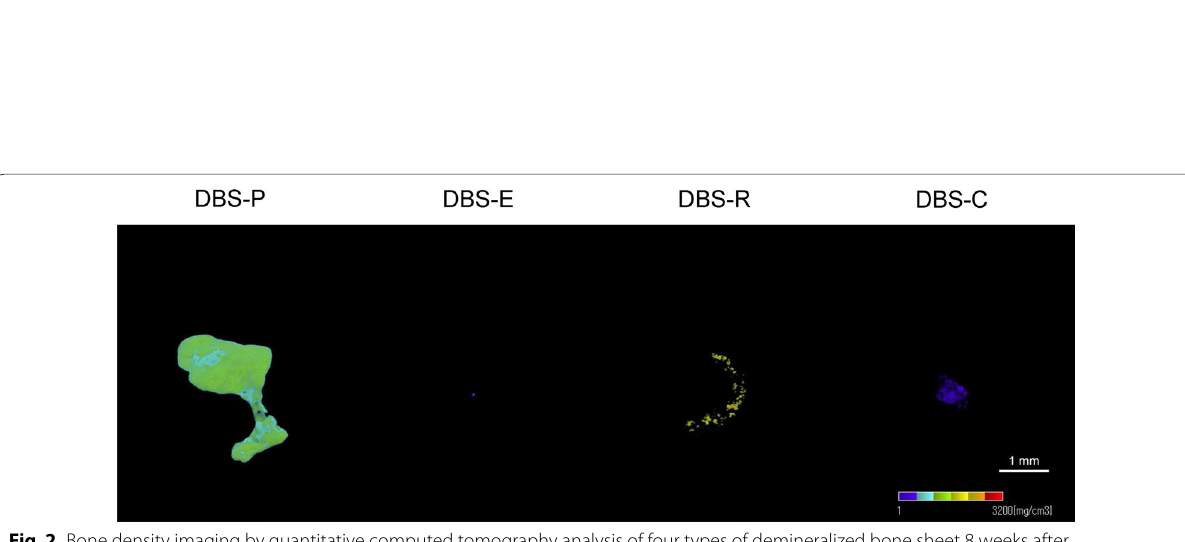
Fig. 2 Bone density imaging by quantitative computed tomography analysis of four types of demineralized bone sheet 8 weeks after transplantation. Imaging conditions: tube voltage, 115 kV; tube current, 70 μA; resolution, 1024 and total scanning time, 900 s. BMD images were generated by taking known phantoms under the same conditions as the demineralized bone sheets and taking the BMD values as pixel values from micro‑CT images. The obtained micro‑CT image was image‑analyzed with three‑dimensional reconstruction